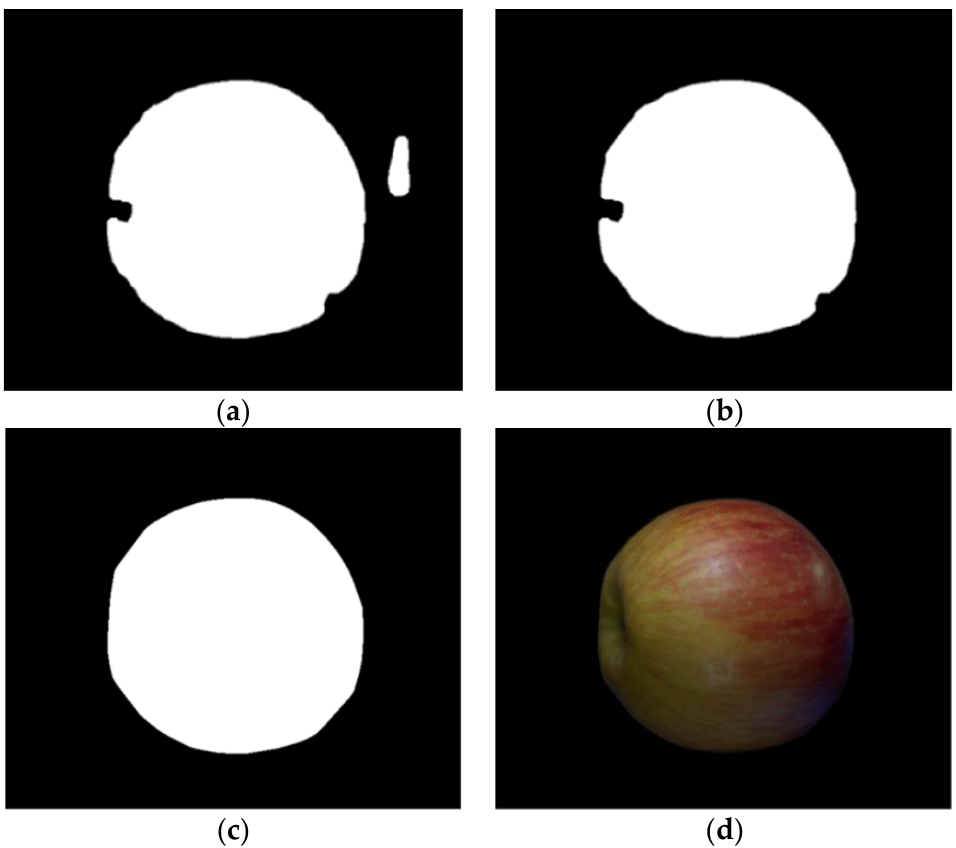
Figure 7. Extracting apple area from a sample image: ( a ) Morphology result; ( b ) Large area selection; ( c ) Convex hull algorithm; ( d ) Apple area.